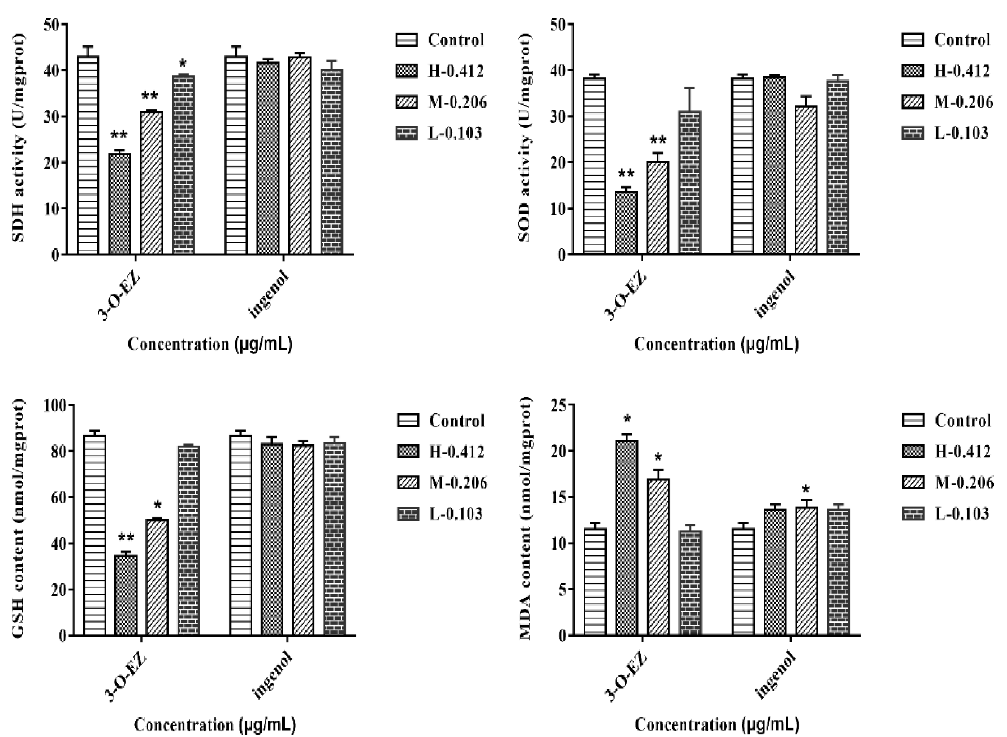
Figure 6. The enzyme activities of SDH and SOD, GSH and MDA content in zebrafish embryos (* p < 0.05, ** p < 0.01 compared to control group).